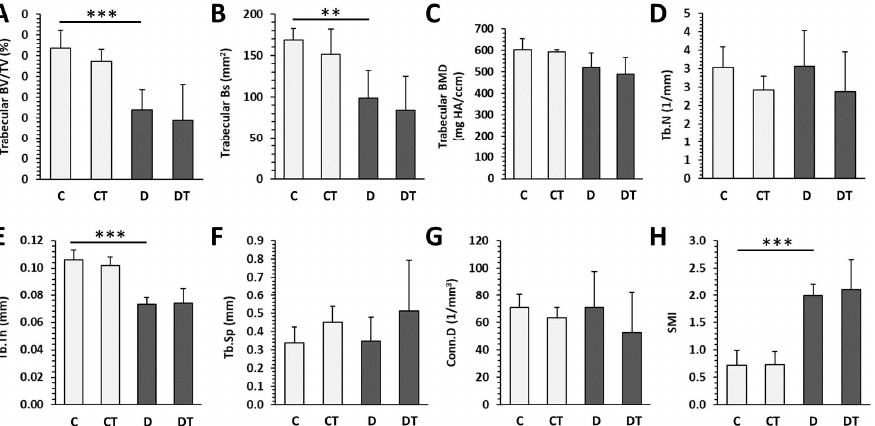
Figure 3. Micro-CT trabecular parameters in non-diabetic rats (C), those treated with cemtirestat (CT), STZ-induced diabetic rats (D), and those treated with cemtirestat (DT). ( A ) Volume fraction (bone volume/total volume; BV/TV), ( B ) bone surface (Bs), ( C ) bone mineral density (BMD), ( D ) trabecular number (Tb.N), ( E ) trabecular thickness (Tb.Th), ( F ) trabecular separation (Tb.Sp), ( G ) connectivity density (Conn.D), and ( H ) structure model index (SMI). The values are represented as mean ± SD. Only differences between groups C and D, as well as C and CT, and D and DT are indicated (** p < 0.01, *** p < 0.001).